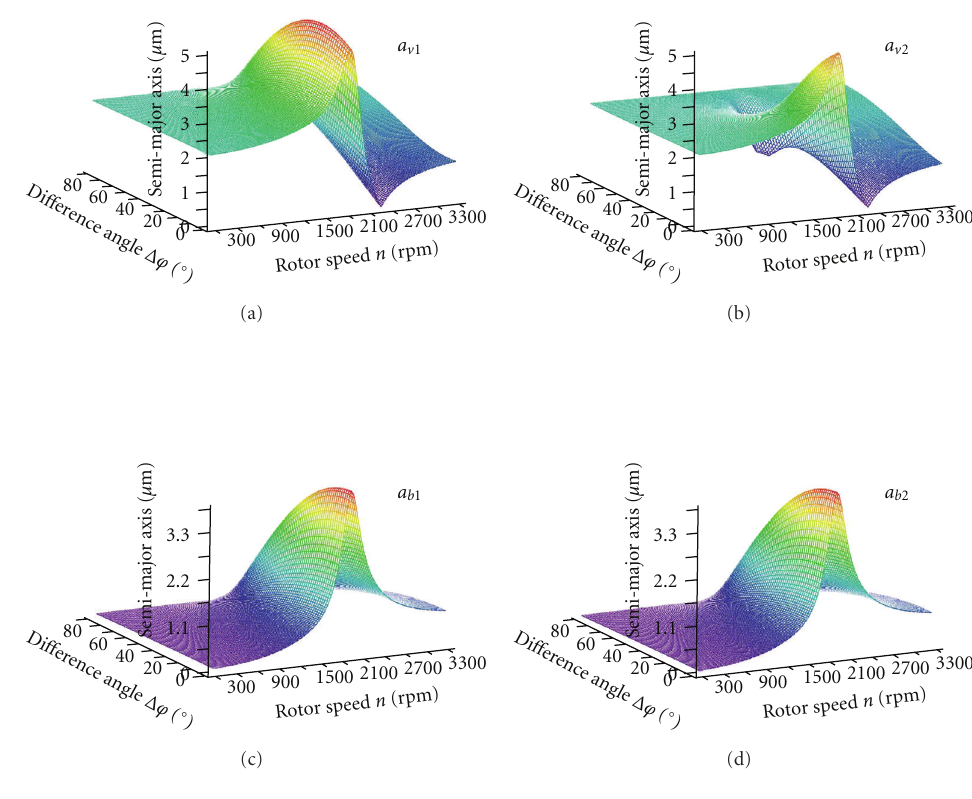
Figure 11: Semi-major axes of the absolute orbits of (a) the shaft journal point V 1 , (b) the shaft journal point V 2 , (c) the bearing housing point B 1 , and (d) the bearing housing point B 2 , depending on the rotor speed n and on the di ff erence angle Δ ϕ .